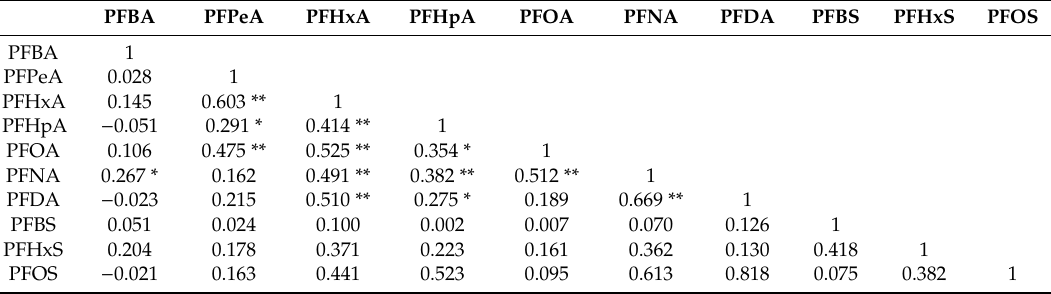
Table 1. Spearman correlation coe ffi cients (two-tailed) for individual PFAS concentrations